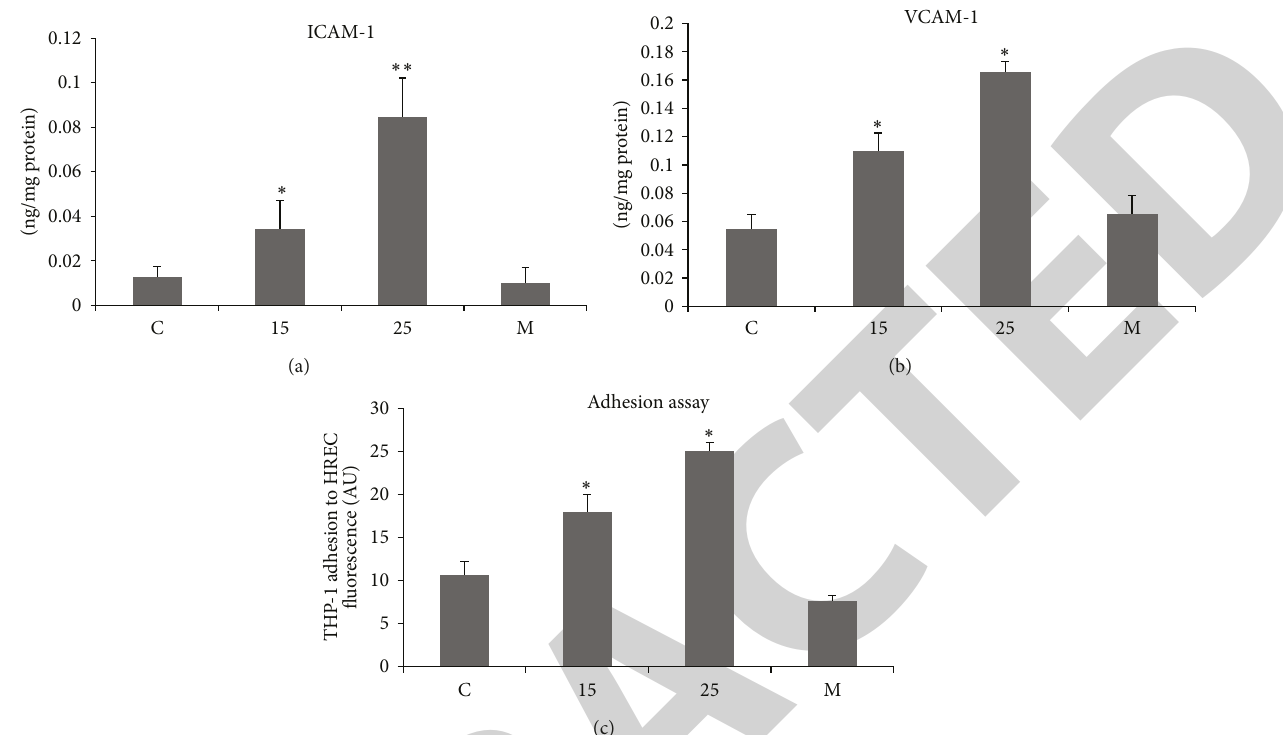
Figure 4: High glucose induced cell adhesion: HMVRECs were incubated and treated with 5.5, 15, and 25 mM glucose and mannitol as described in Methods and legend of Figure 1. Thereafter cell supernatants were collected for ELISA. Adhesion assay is described in Methods section. (a) Increased ICAM-1 levels with HG. ∗ 𝑃 < 0.01 versus controls and ∗∗ 𝑃 < 0.001 versus controls, (b) increased sVCAM-1 levels with HG. ∗ 𝑃 < 0.001 versus controls; (c) cell adhesion assay showing increased cell adhesion with HG. ∗ 𝑃 < 0.001 versus